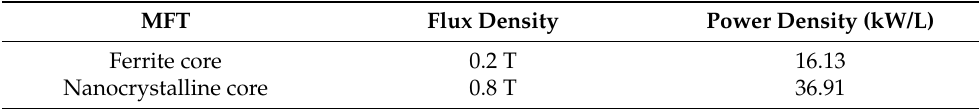
Table 3. Volume and weigh of both MFTs. Table 4. Power density in kW/L of the